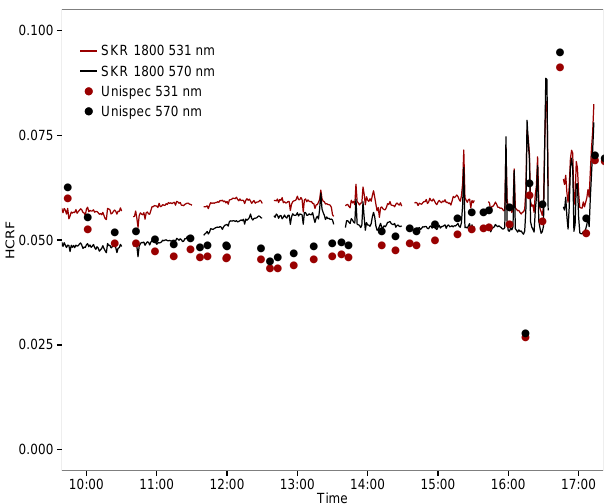
Figure 8. Hemispherical–conical reflectance factors (HCRFs) at 531 and 570nm obtained by a UniSpec and SKR 1800 sensor pair, as a function of time of day. Data were collected over a lodgepole pine ( Pinus contorta ) canopy and corrected to reflectance using cross-calibration functions determined from white panel measure- ments. Only data that were collected within the time frame of white panel measurements are shown. Data shown have not been normal- ized to correct for the SRF differences between